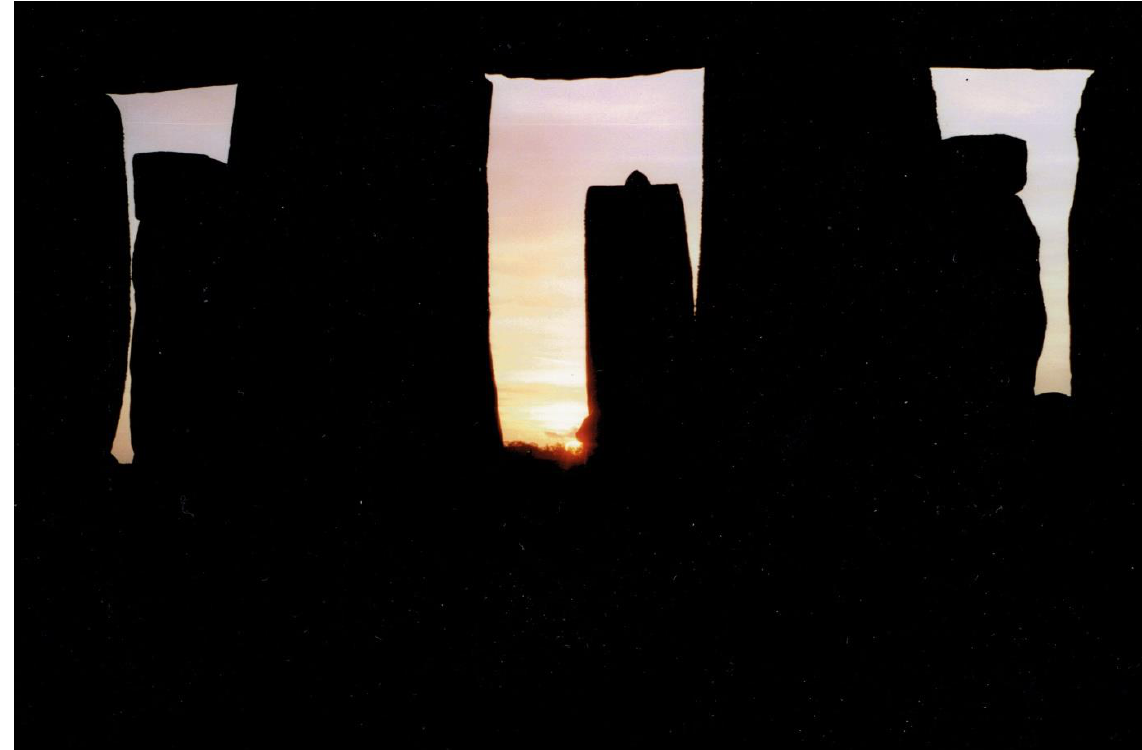
Figure 13. View from the Heel Stone of the sun setting between Stone 56 and the now prone companion Stone 55. (Photograph by the